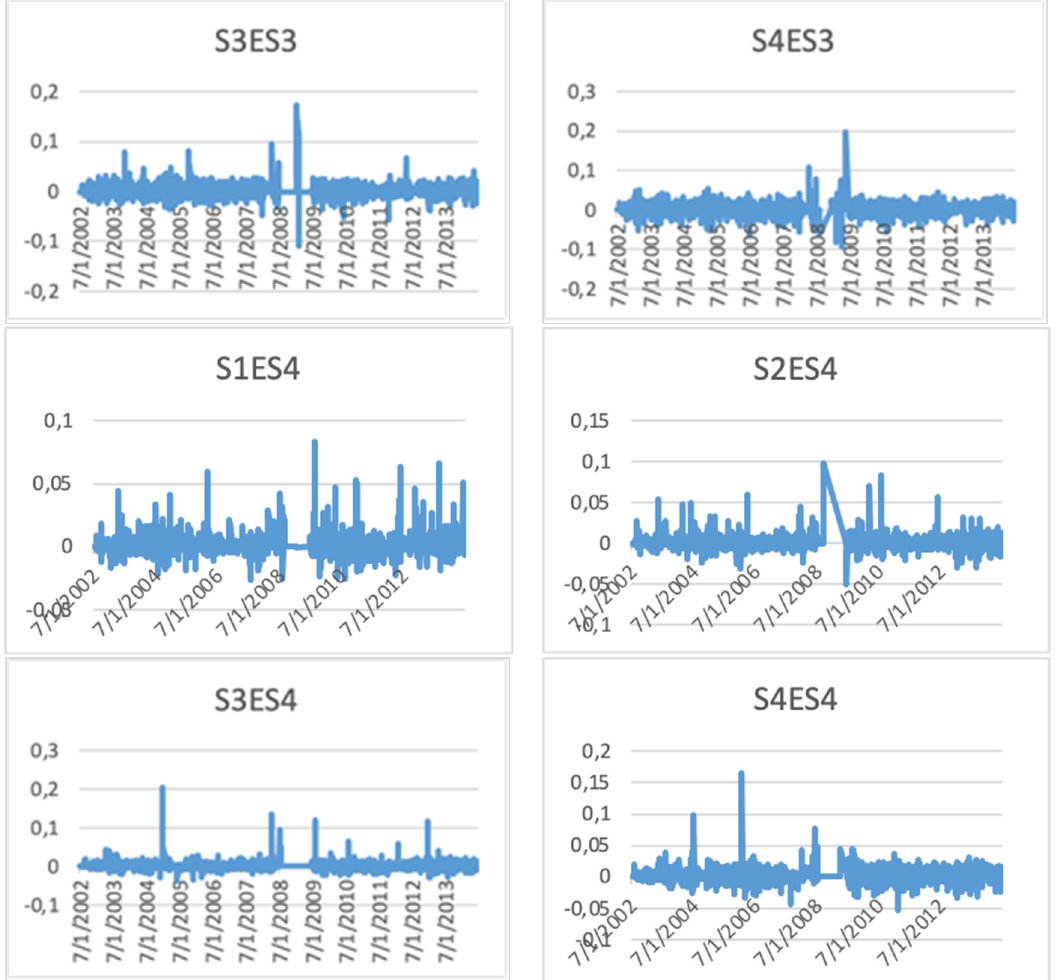
Figure A5. Daily Returns of Size (S) and ES Portfolios (95% Level of Confidence) (ES1 is the Lowest Expected Shortfall Portfolio Quartile ad ES4 Represents the Highest Expected Shortfall Portfolio Quartile).